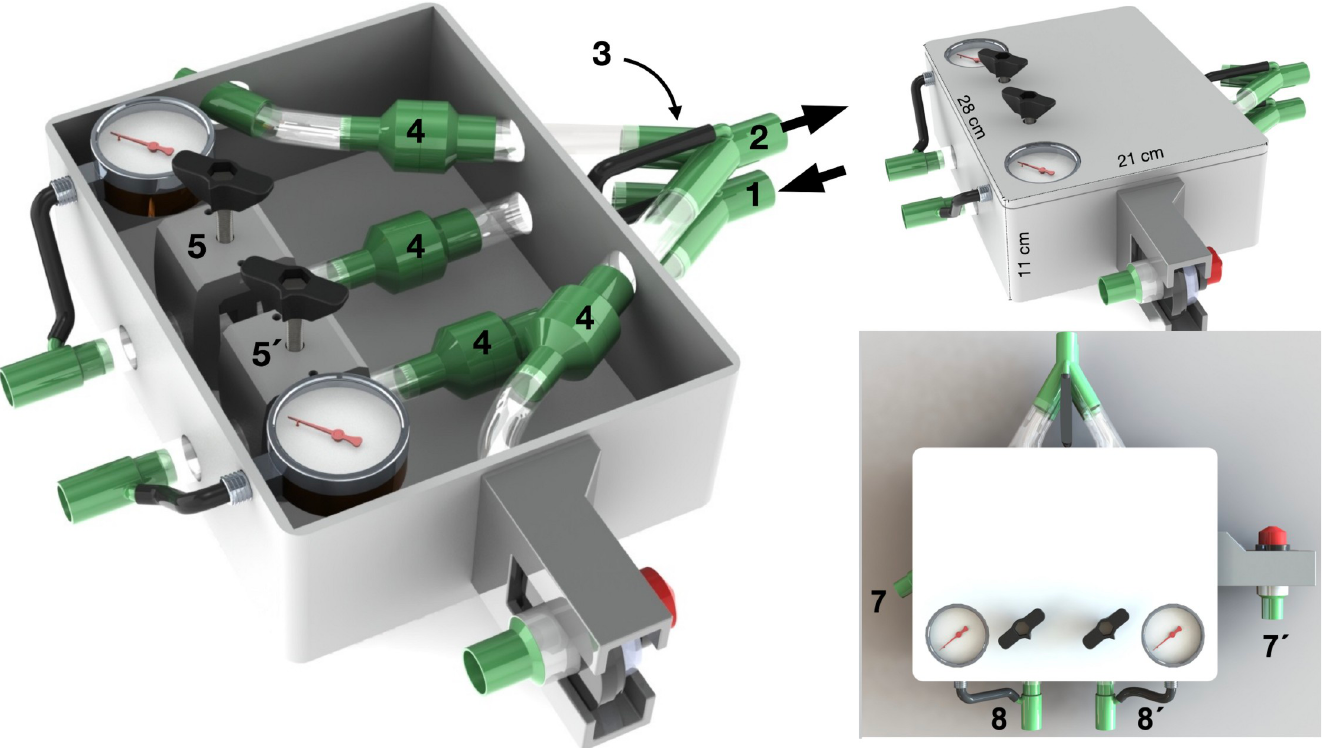
Fig 2. Three-dimensional volume renderings of the ACRA interface. (1) Connection for inspiratory limb from ventilator, (2) connection for expiratory limb to ventilator, (3) bypass circuit, (4) unidirectional valves, (5) and (5’) pinch valves, (6) adjustable PEEP valve, (7) and (7’) connection for expiratory tubes from paired units, (8) and (8’) connection for inspiratory tubes to paired